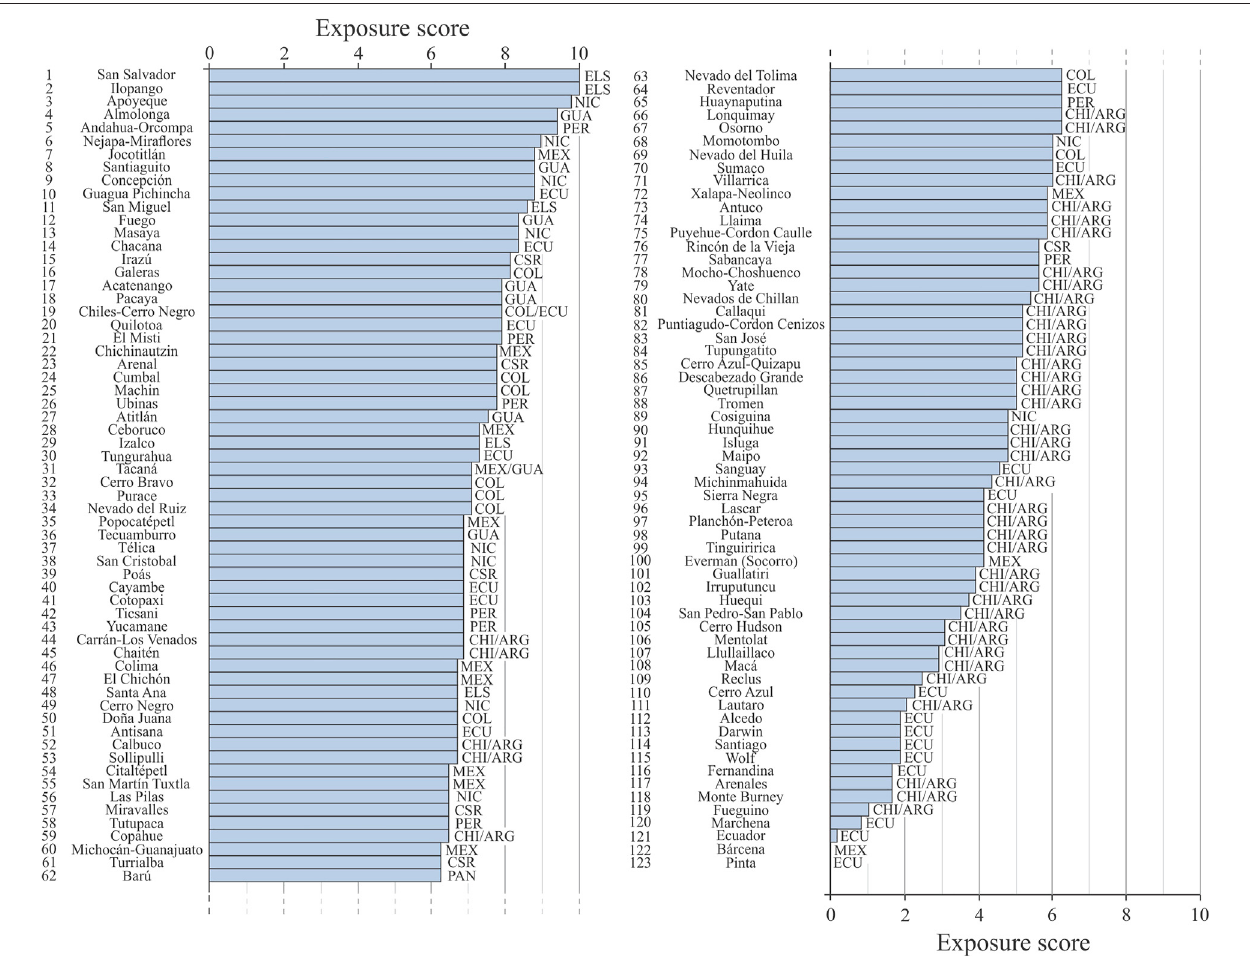
FIGURE 5 | Latin America volcanic systems with recorded activity in the past 1,000 years assessed based on their exposure score. CHI/ARG: Chile/Argentina; COL: Colombia; CSR: Costa Rica; ECU: Ecuador; ELS: El Salvador; GUA: Guatemala; MEX: México; NIC: Nicaragua; PER: Peru.